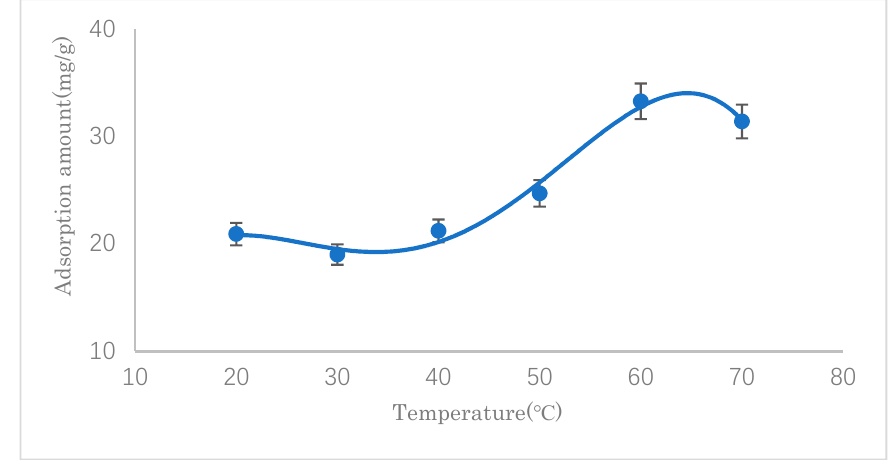
Figure 9. Effect of temperature on SDS adsorption.